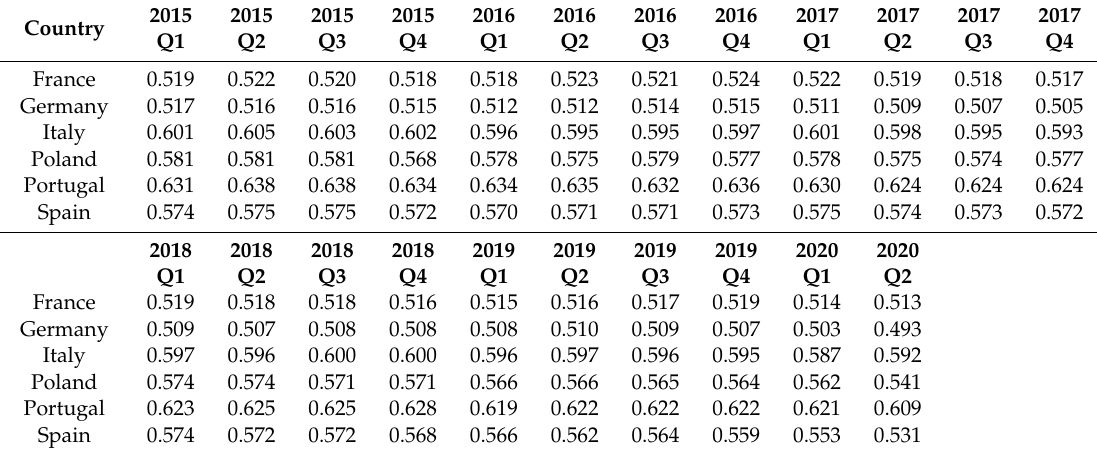
Table 1. Factor propensity to private consumption, own work, source: